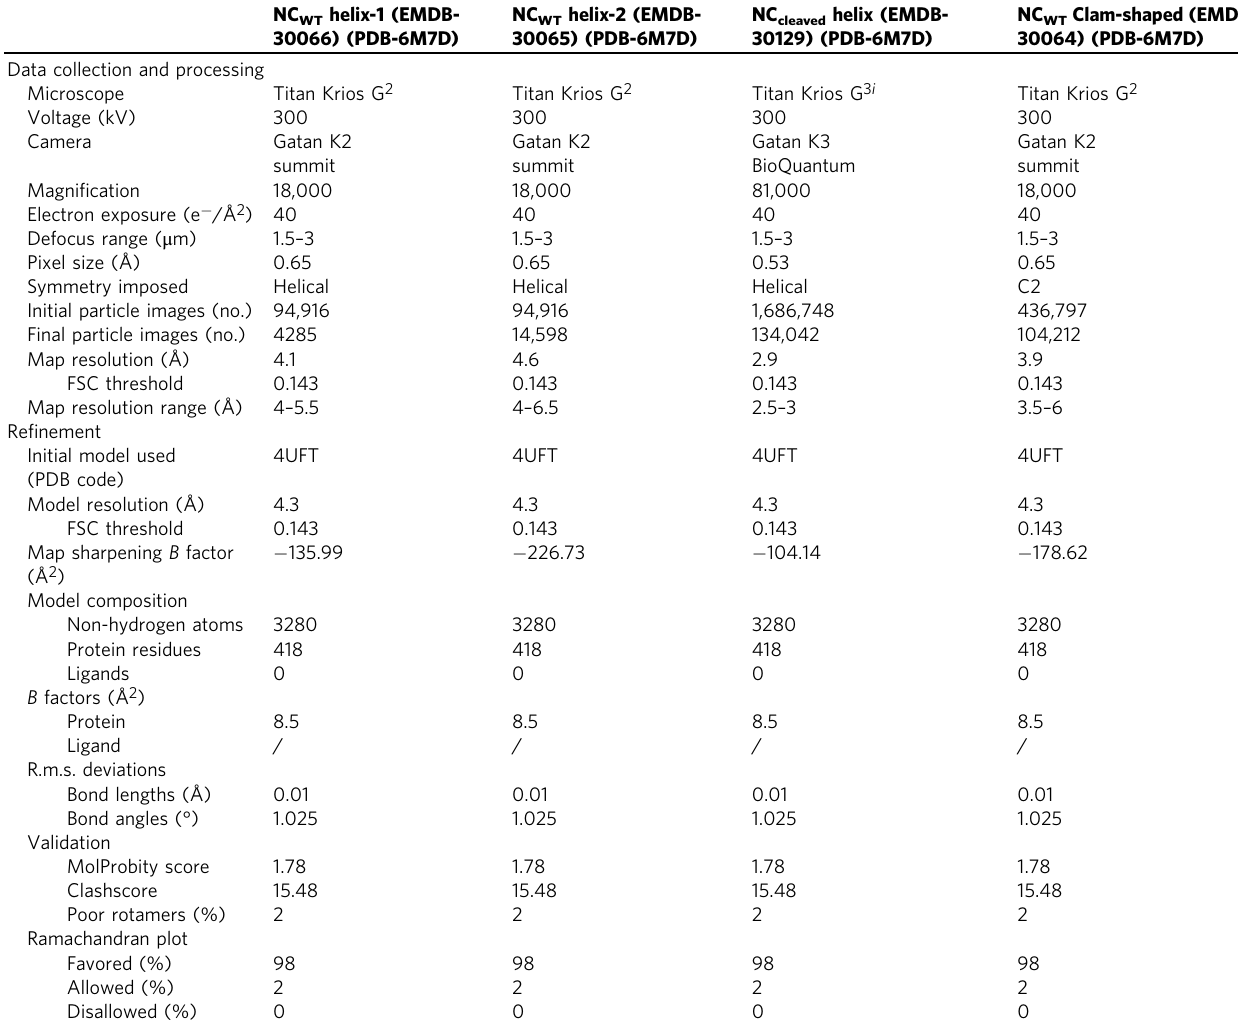
Table 1 Cryo-EM data collection and data processing